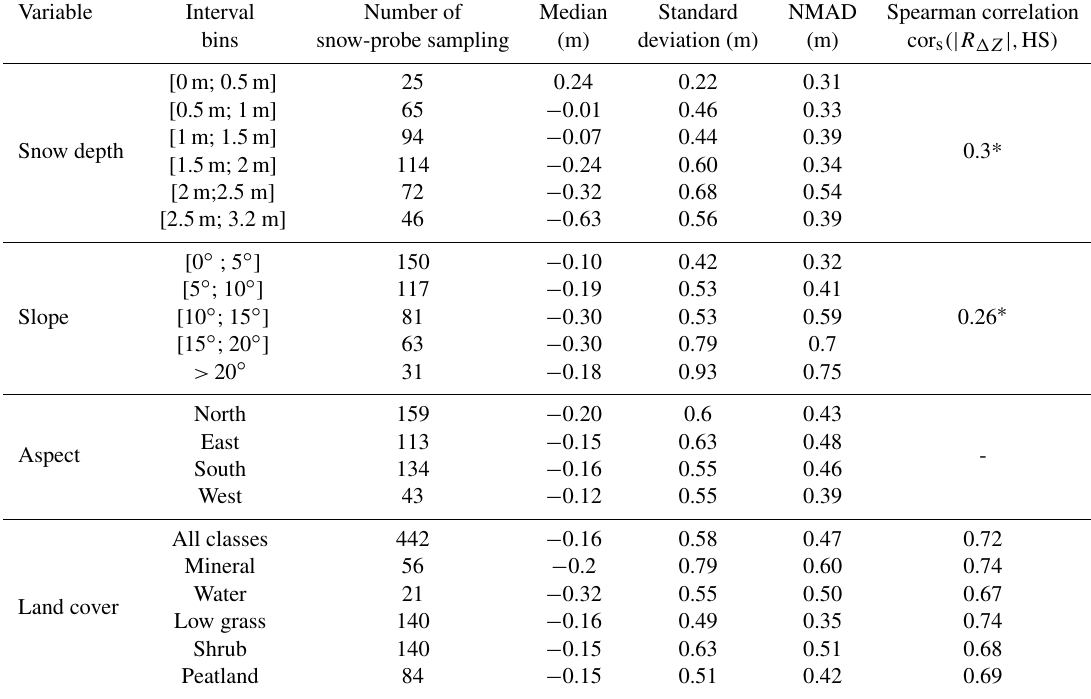
Table 5. Statistics relative to the comparison between the 2m Pléiades dDEM (tri-stereo) and the snow-probe measurements, according to the snow depth, slope and aspect, and the land-cover classes. Significant correlations ( p values < 0.05) are marked with asterisks. NMAD means normalized median absolute deviation (Höhle and Höhle,